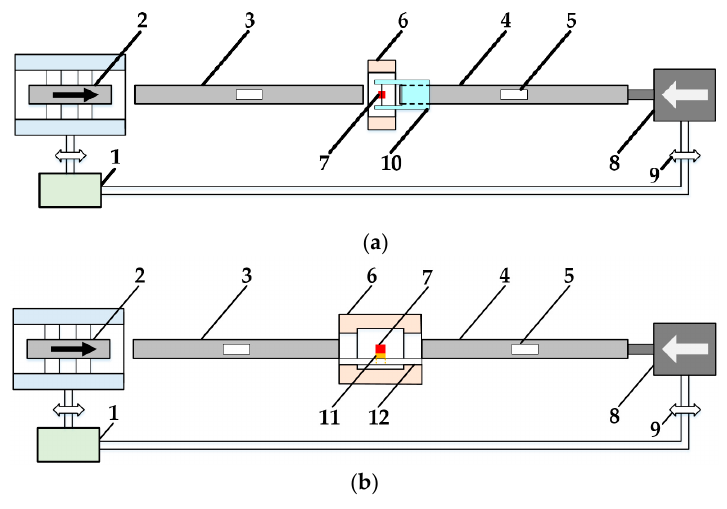
Figure 2. SHPB devices: ( a ) fine loading bars for Φ 2 × 2 samples at high strain-rate; ( b ) coarse loading bars for Φ 3 × 3 samples at low strain-rate. 1—air chamber; 2—strike bar; 3—incident bar; 4—transmission bar; 5—strain gauge; 6—furnace; 7—sample; 8—synchronous device; 9—valve; 10—clamping device; 11—heat insulation block; 12—guide rail.